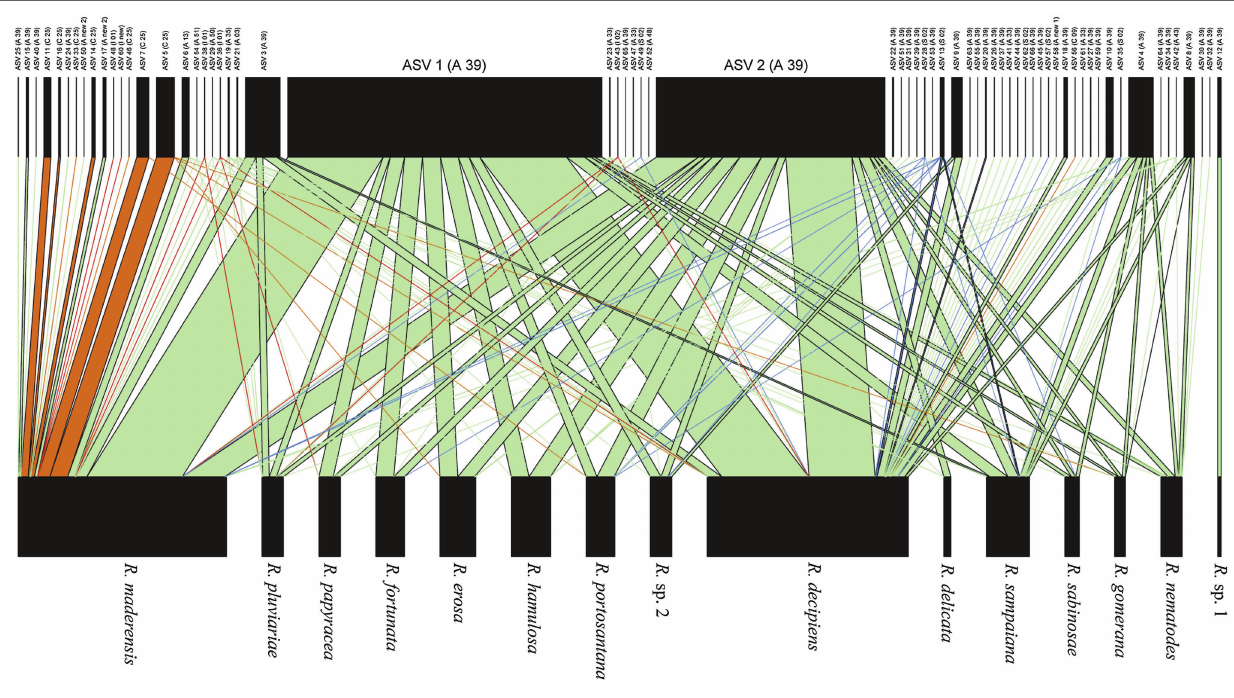
FIGURE 4 | Bipartite network based on rarefied reads showing interactions between Ramalina species and Trebouxia ASVs. Interactions with ASVs belonging to Trebouxia clades A, C, I, and S are depicted in green, orange, red and blue, respectively. Width of the links is proportional to the frequency of the